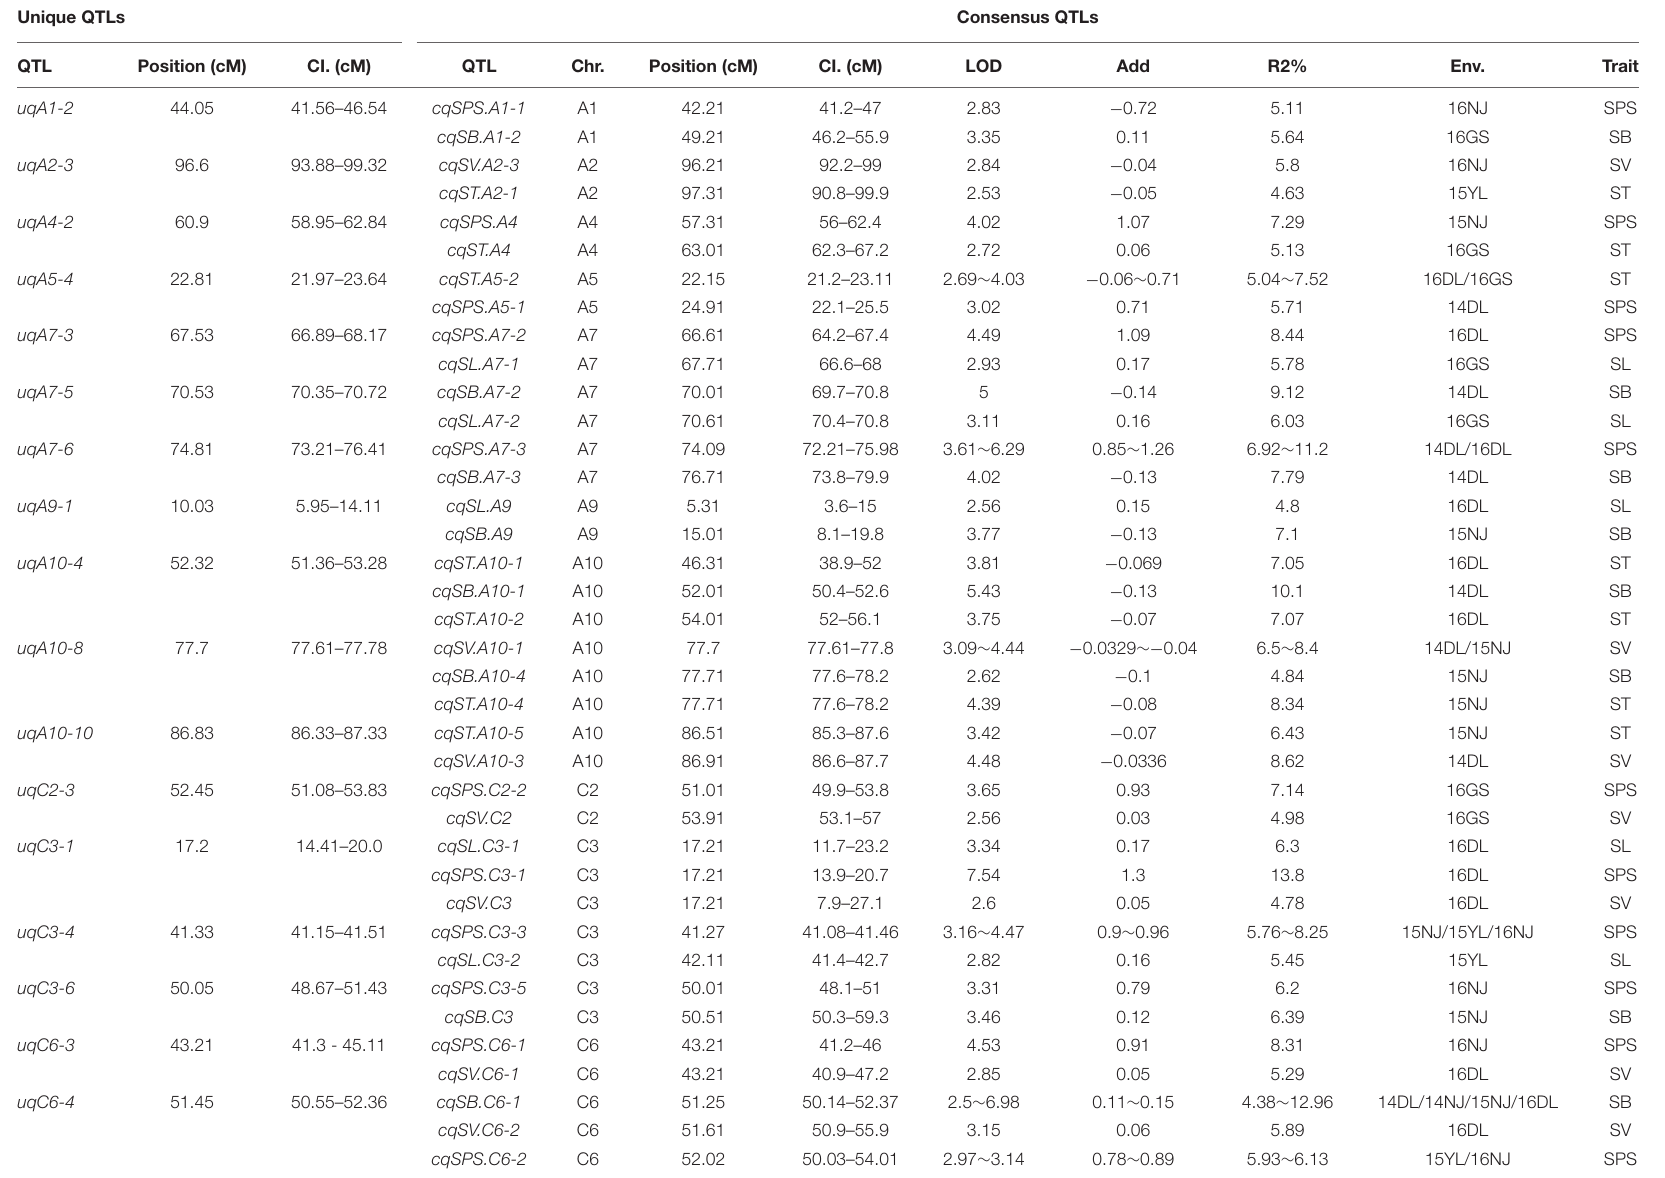
TABLE 4 | Twenty-five pleiotropic unique QTL on two to three traits of silique-related traits obtained by the second round of